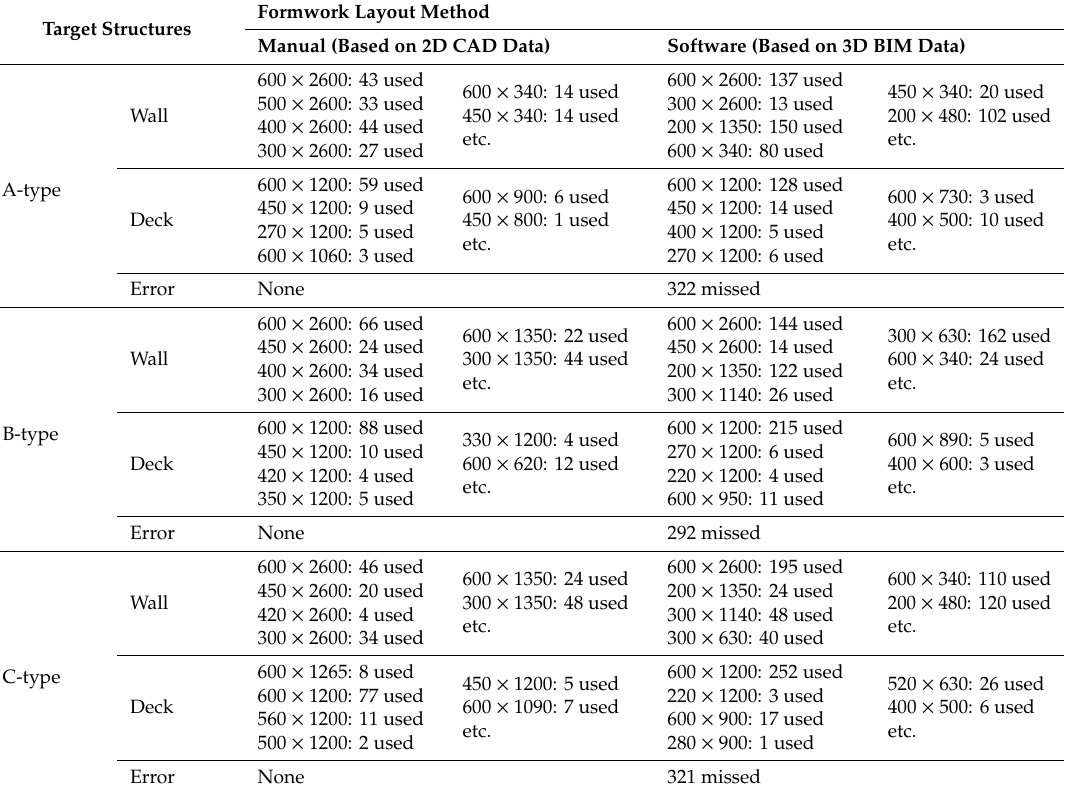
Table 1. Formwork layout